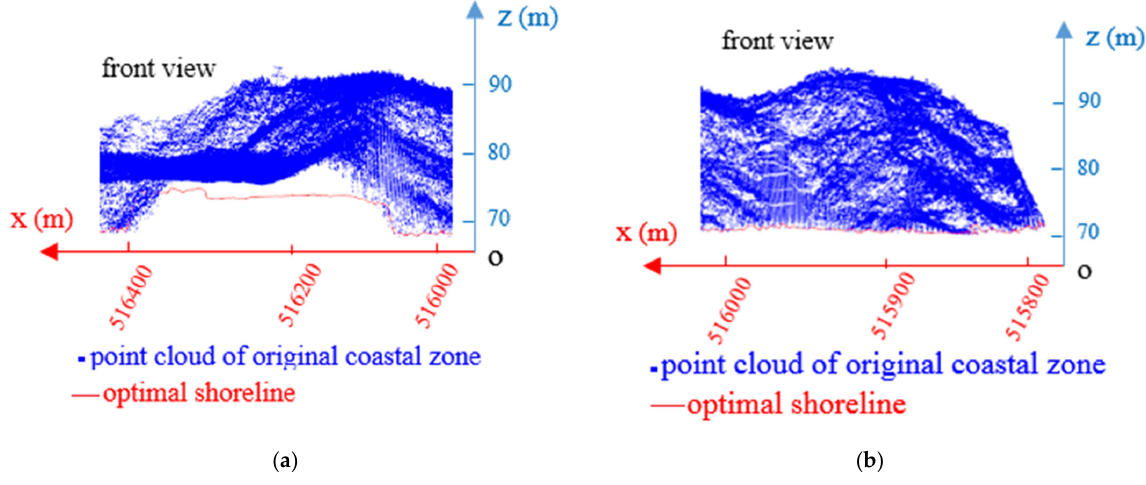
Figure 14. ( a ) The enlarged view of block 1; ( b ) The enlarged view of block